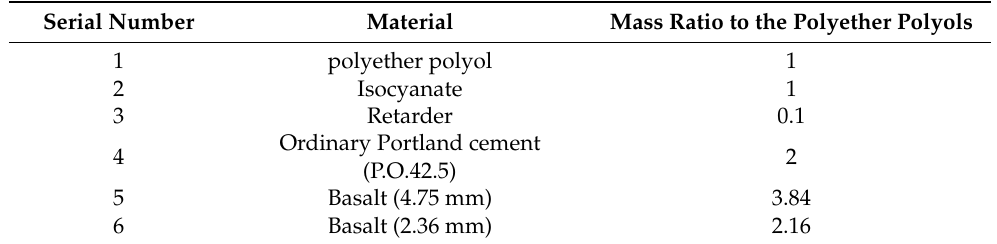
Table 4. Composition of polyurethane concrete.